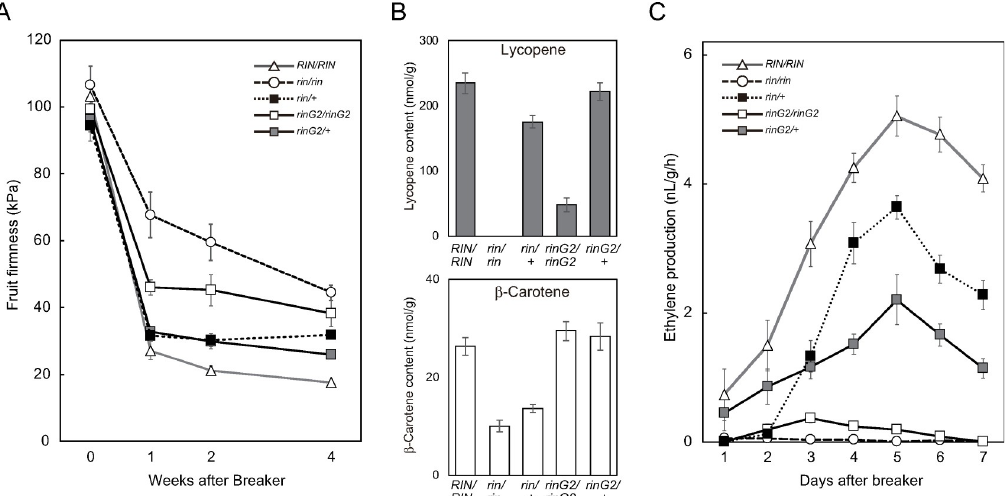
Fig 3. Fruit softening, carotenoid accumulation, and ethylene biosynthesis in rinG2/+ . A. Firmness of fruits with mutations in the rin locus. Fruits harvested just before the breaker stage were examined as 0 week samples. Breaker stage fruits were harvested and examined at 1, 2, and 4 weeks after harvest. Data represent the means ± SE of five biological replicates. B. Lycopene and β -carotene contents of fruits with mutations in the rin locus. Fruits were harvested at 10 days after the breaker stage. Data represent the means ± SE of five or six biological replicates. C. Ethylene biosynthesis in fruits with mutations in the rin locus. Fruits just before the breaker stage were harvested and examined daily. Data represent the means ± SE of at least four biological replicates.